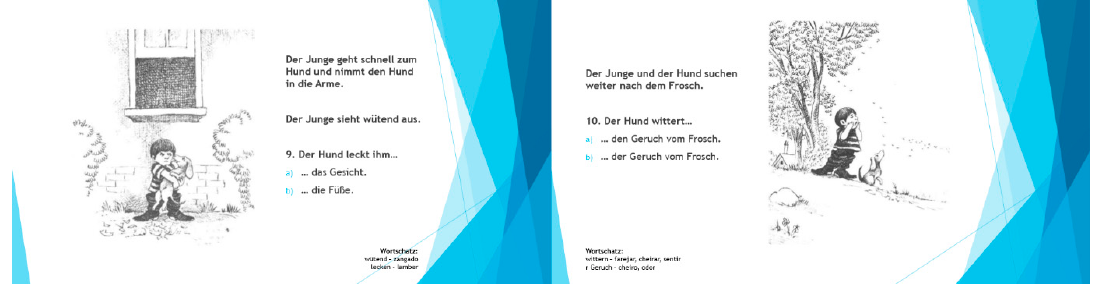
Figure A31. Posttest: Binary-choice recognition task.